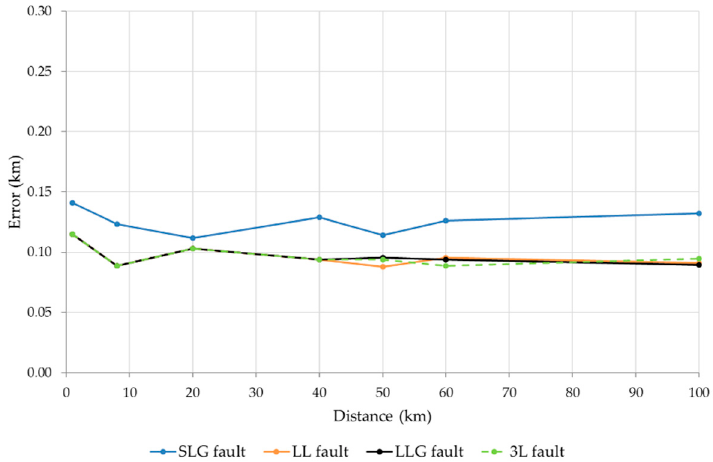
Figure 12. Distance errors for different faults (SLG, LL, LLG and 3L) with a very low inception angle (0 ° ), a soil resistivity of 200 Ω ∙ m and R f = 150 Ω .